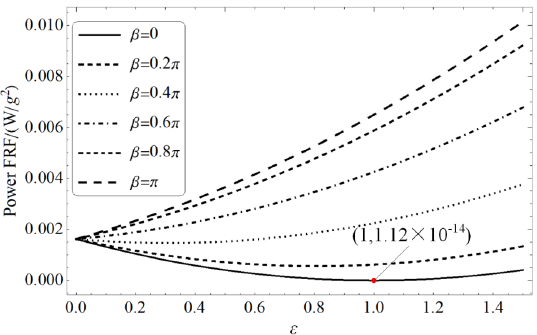
Figure 7. The comparison under low-frequency excitation ( a 2 = 0 . 5, ε = 1, and β = 0 . 3 π ). Table 1. Comparisons of maximum output power at four frequen-